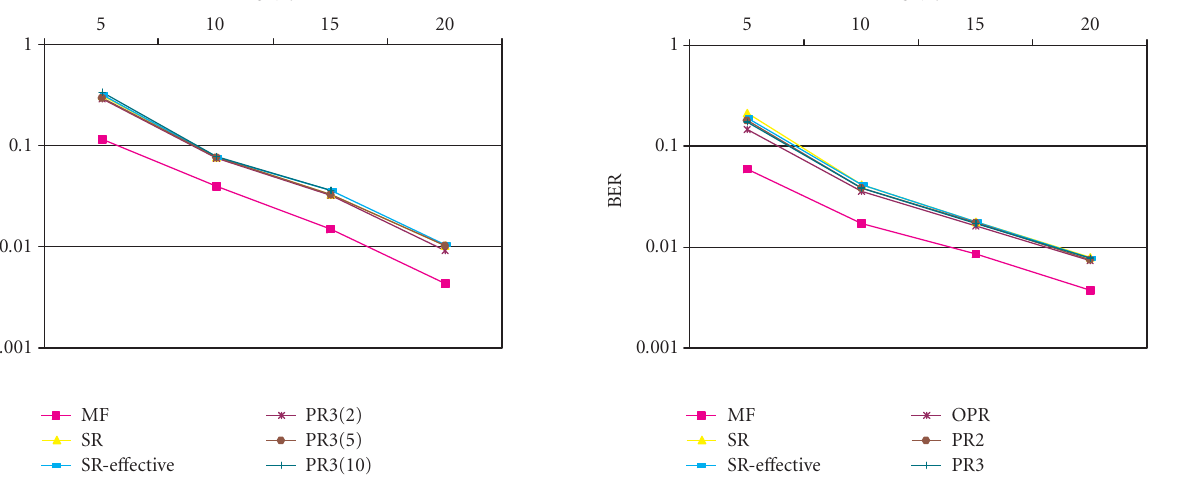
Figure 5: Performance of the PR3 algorithm for di ff erent threshold values applied to joint detection and estimation.